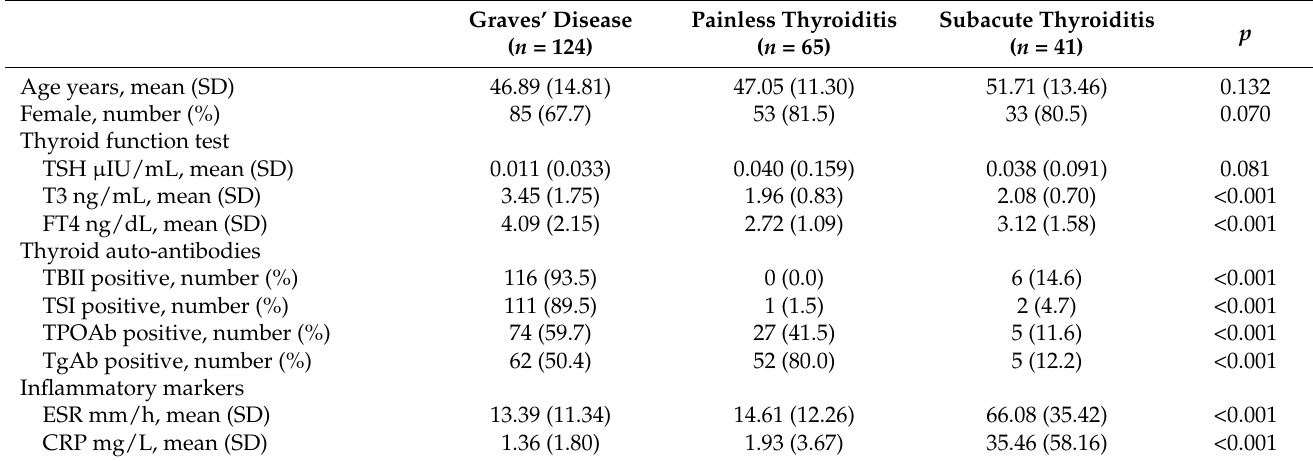
Table 1. Baseline characteristics of the study cohort. Graves’